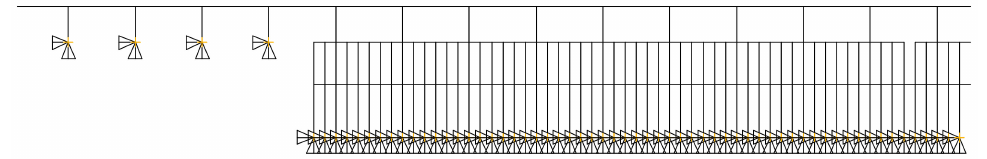
Figure 3. Layout of nodes and elements of the CRTS III slab track–subgrade sub-model. A static wheel load is applied to the central part and the left part in the sub-model, respectively, to calibrate the stiffness of the track foundation in the left and right parts. The equivalent stiffness of the track foundation is determined according to the relative error between the maximum vertical rail displacements of the central part and those of the side part and is less than 10 − 6 . Detailed procedures can be found in Reference